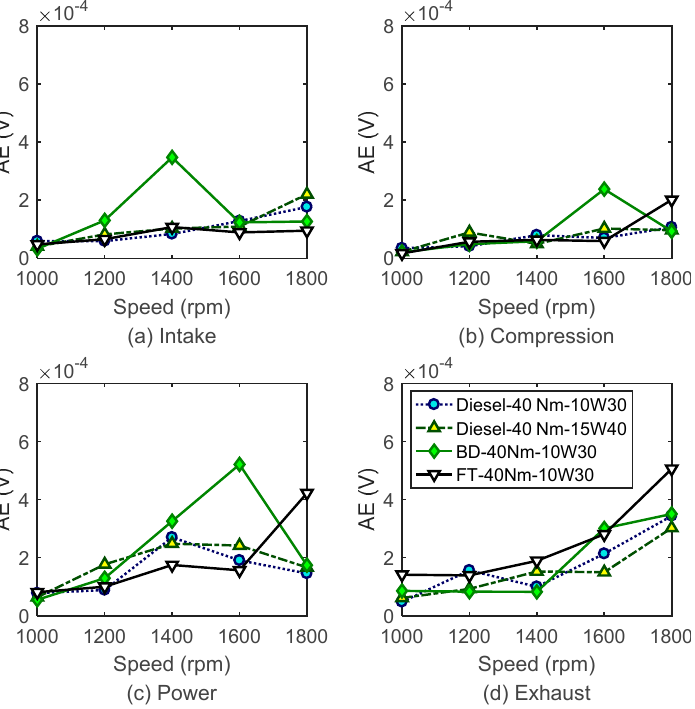
Figure 15. AAC–AE indicators of different alternative fuels under high load: ( a ) Intake; ( b ) Compression; ( c ) Power; ( d ) Exhaust.